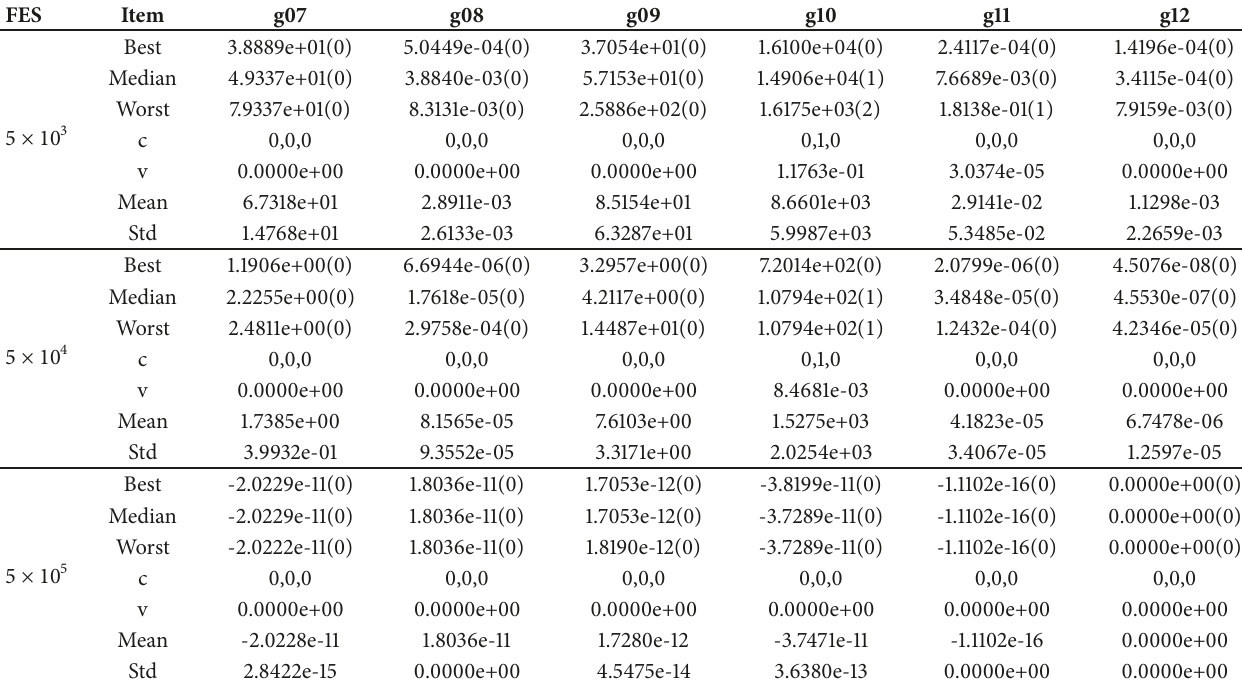
Table 3: General performance in terms of function error values achieved by CADE for test functions g07-g12.